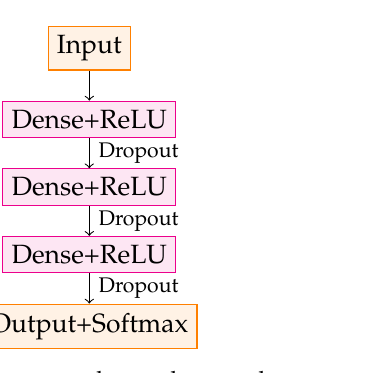
Figure 5. Architecture of NNs used for classification. Figure ( a ) shows the FC. Fully-connected (dense) layers were used in combination with the rectified linear activation function (ReLU) and the softmax activation function in the output layer. Dropout layers were inserted to reduce overfitting. Figure ( b ) visualizes the structure of the CNN, with 1D-convolutional and pooling layers being fundamental to this network type. Table 2. Hyperparameters used for the networks FC and CNN depending on the four classifiers RAD, ANG, MAGN and